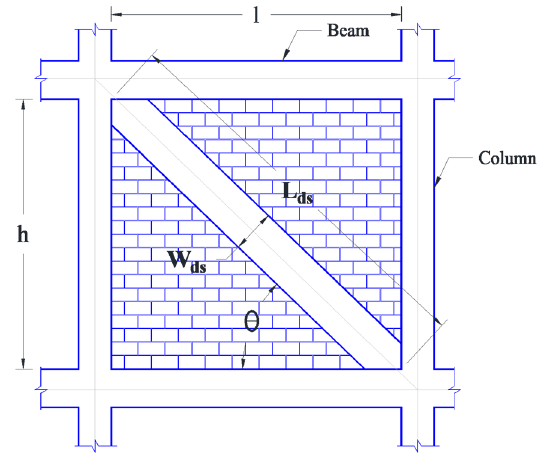
Figure 6. Equivalent strut model for masonry infills.